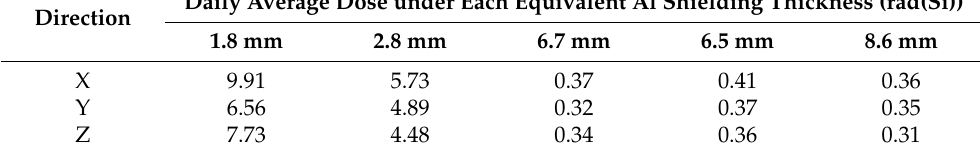
Table 7. The daily average dose under different shielding thicknesses in each direction.